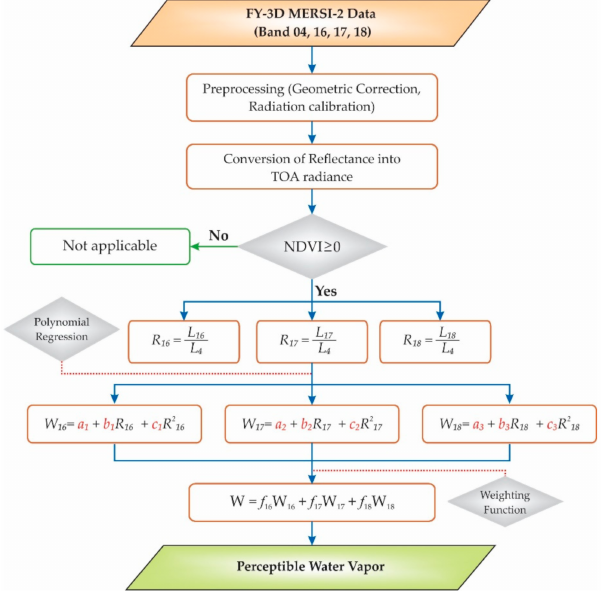
Figure 4. The framework representing the regression steps in the development of the